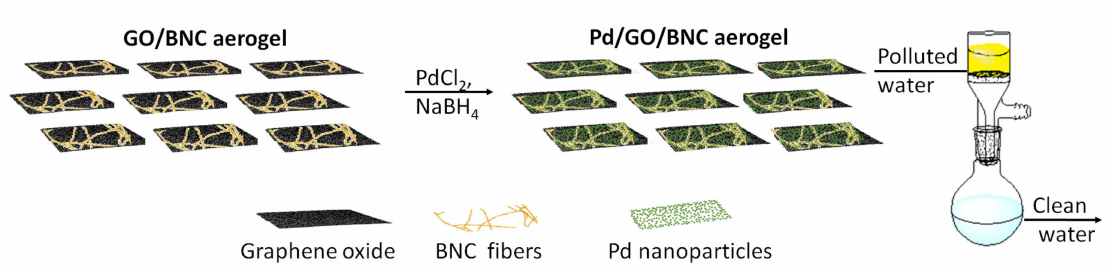
Figure 1. Schematic illustration of the steps involved in the fabrication of Pd/graphene oxide (GO)/bacterial nanocellulose (BNC) and its